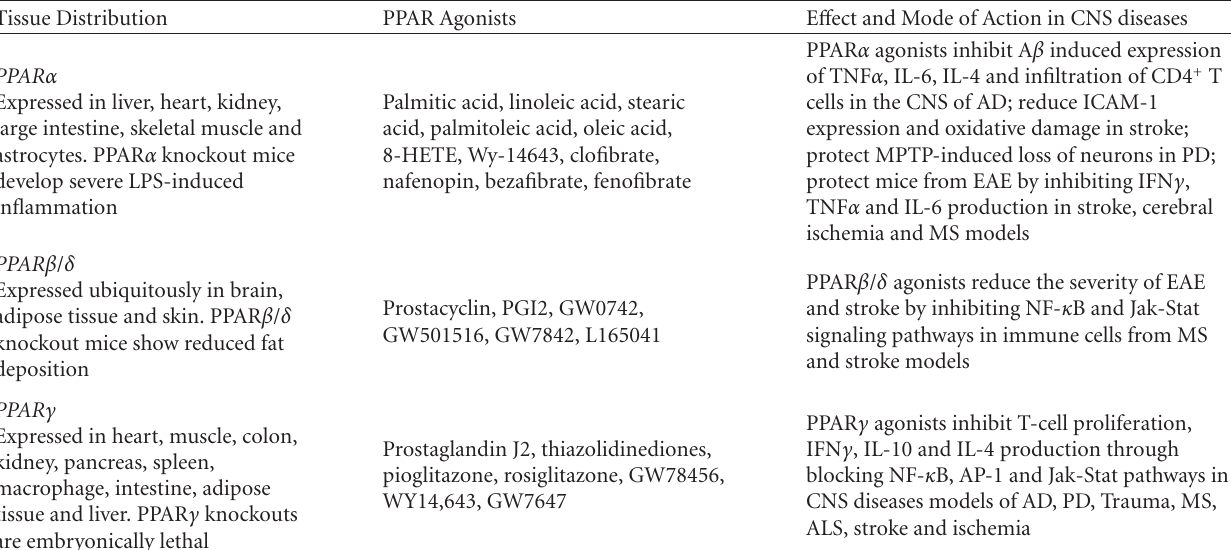
Table 2: Role of PPARs in the regulation of inflammatory signaling pathways in CNS